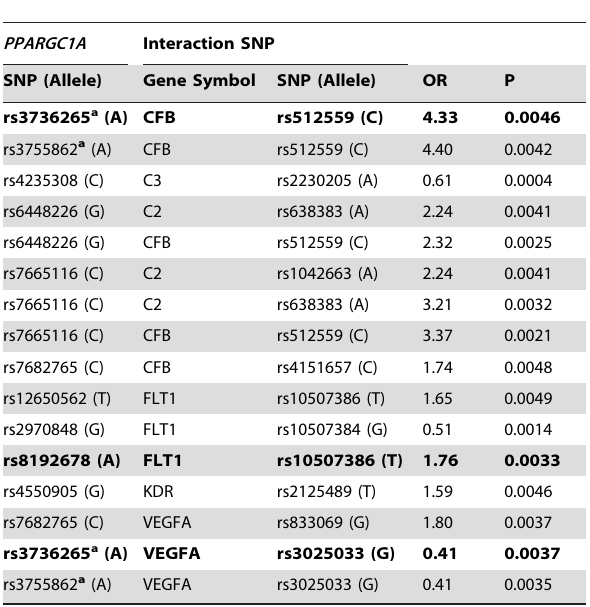
Table 3. Summary of interaction analysis of PPARGC1A SNPs and SNPs in complement and VEGF genes for NV AMD in combined